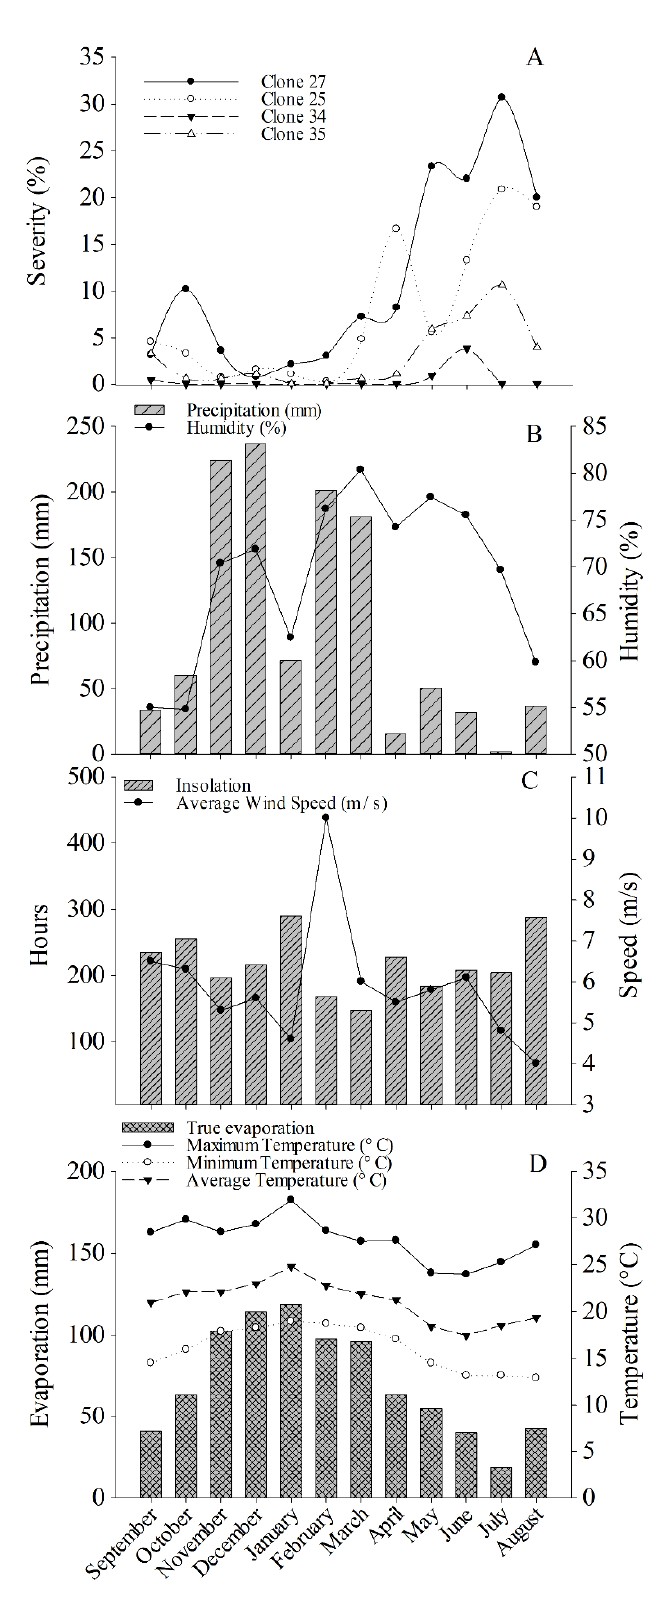
Figure 3. ( A ) Rust severity progress curve of candeia clones representative of each significance group. ( B ) Monthly means of climatic variables: relative humidity (%) and cumulative monthly rainfall. ( C ) Mean wind speed (m / s) and insolation (h / month). ( D ) Mean, maximum, and minimum temperatures (°C) and actual evapotranspiration (mm) in the period from September 2016 to August 2017.